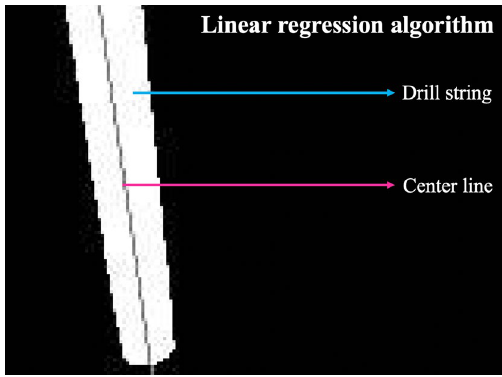
Fig. 15 Line detection